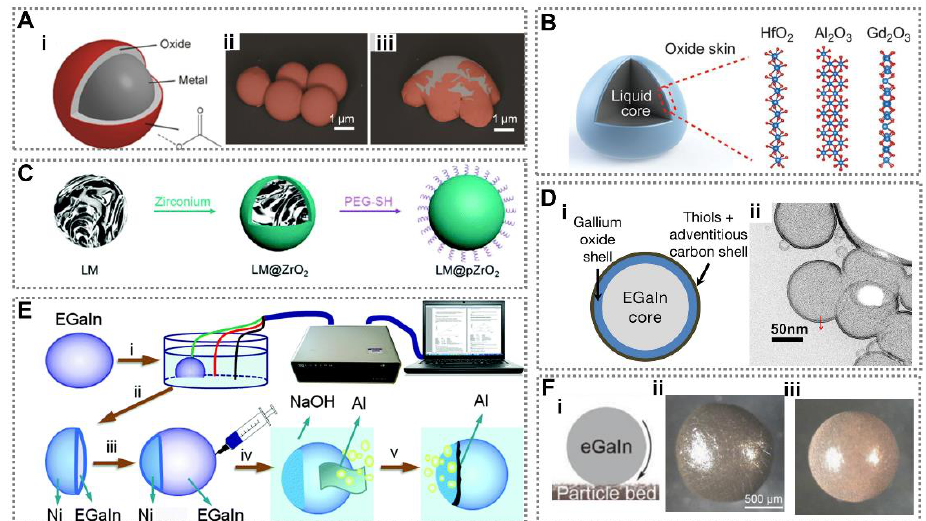
Figure 4. Liquid metal (LM) droplets with core-shell structure. ( A ) Schematic of LM droplets with core-shell structure and the false-colorized images of droplets to highlight the fractured oxide layer. Reprinted from Ref. [93]. ( B ) A cross-sectional diagram of a LM droplet, with possible crystal structures of different oxide layers. Reprinted with permission from ref. [96]. Copyright 2017, The American Association for the Advancement of Science ( C ) Schematic diagram of the synthesis route of LM nanodroplets. Reprinted with permission from ref. [24]. Copyright 2019, Spring Nature. ( D ) Schematic diagram and pretreated scanning transmission electron microscopy (STEM) image of LM droplets with core-shell structure. Reprinted with permission from ref. [97]. Copyright 2017, American Chemical Society. ( E ) Schematic diagram of fabrication of the magnetic soft motor with core-shell structure [98]. Copyright 2016, The Royal Society of Chemistry ( F ) Formation of thin porous particle networks at LM droplet interface. Reprinted with permission from ref. [25]. Copyright 2018, John Wiley and Sons.